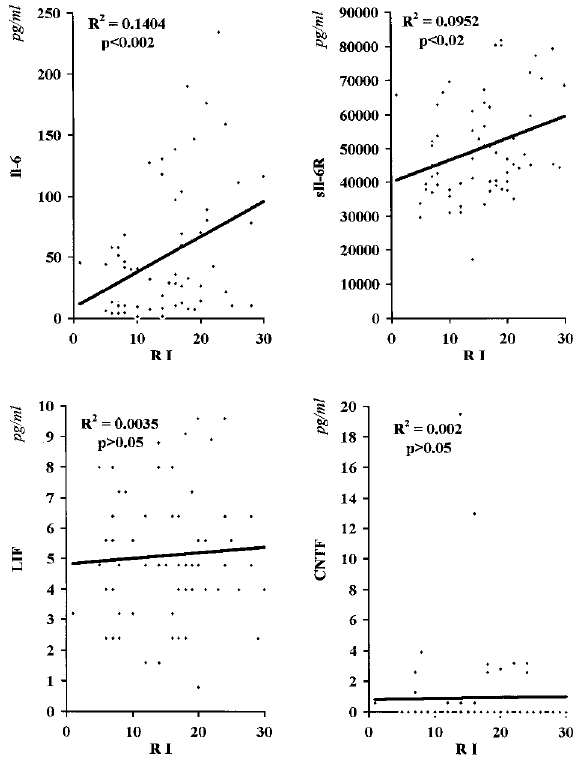
FIG. 1. Correlation between serum concentrations of IL-6, sIL- 6R, LIF and CNTF with disease activity according to Ritchie’s index (RI) in patients with rheumatoid arthritis (RA).